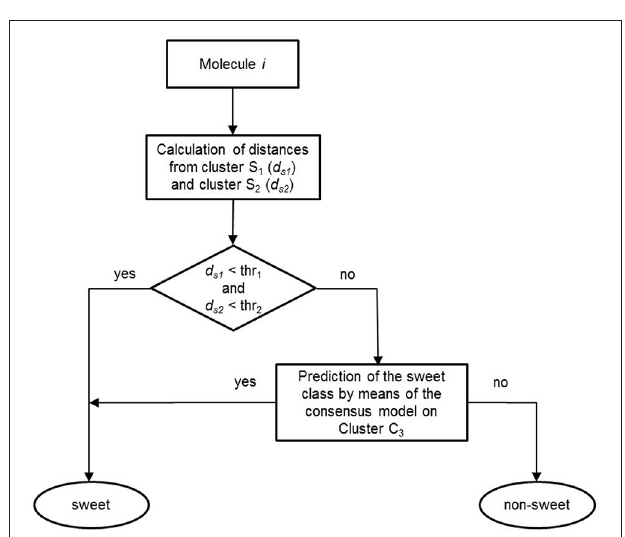
FIGURE 4 | Workflow of the basic steps of the QSTR-based expert system for predicting the sweetness of chemicals.